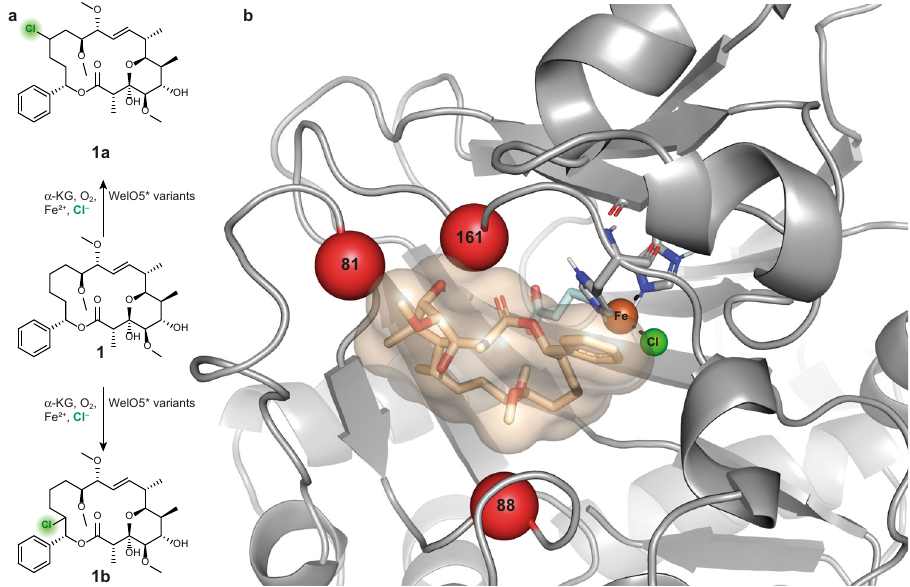
Fig. 2 Identi fi cation of target sites for enzyme engineering. a Regio-divergent halogenation of soraphen A in function of the employed WelO5* variant. b Docking of soraphen A (wheat) into a model of variant WelO5* V81G/I161P (gray). The enzyme model was created using SWISS-MODEL 56 and the crystal structure of WelO5 (PDB ID: 5J4R) as a template. Soraphen A was docked using AutoDock Vina 77 . The red spheres indicate the targeted positions for the full randomization library. Histidine residues and the α -ketoglutarate (pale cyan) in complex with the iron (orange sphere) are shown as sticks. The chlorine coordinating to the iron is shown as a green